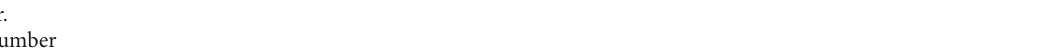
Table 3: Advantages and disadvantages of UASB reactor